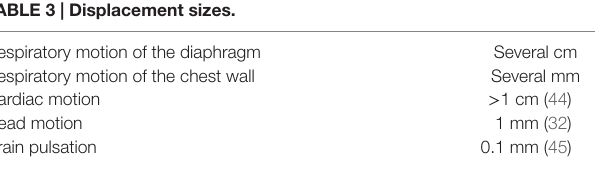
TABLe 3 | Displacement sizes.